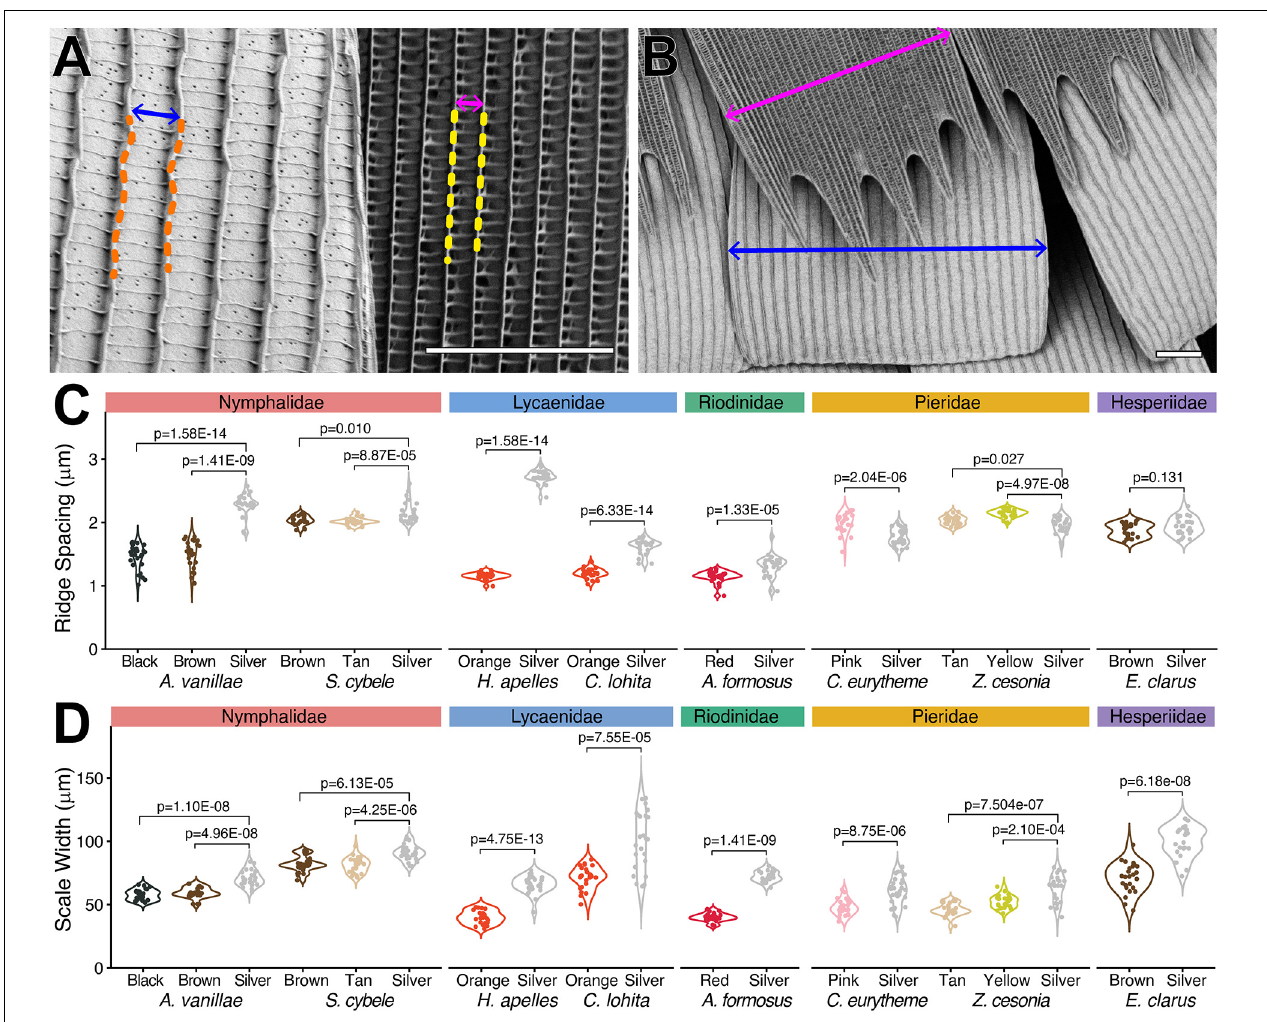
FIGURE 3 | Reflective scales tend to have larger ridge intervals and wider surfaces. (A) Measurement of ridge distance in the metallic (14) vs. orange scales (13) of H. apelles . (B) Measurement of maximal scale width in the metallic (14) vs. orange scales (13) of H. apelles . (C) Ridge distances across metallic vs. adjacent scale types from eight species ( N = 25 scales per scale type). Each measurement corresponds to the Fourier mode, or average ridge interval per scale, extracted from the transversal pixel intensity across a single scale SEM. Pairwise differences show significant p -values following Mann-Whitney U tests. Pierid silver scales are the only metallic scales with smaller ridge intervals compared to adjacent scale types. (D) Maximal scale width distances across metallic vs. adjacent scale types from eight species ( N = 25 scales per scale type). All metallic scales are enlarged compared to adjacent scales types ( p -values, Mann-Whitney U tests). Scale bars, (A,B) = 10 µ m. SEM image datasets are accessible on the Dryad online repository (Day et al., 2020).